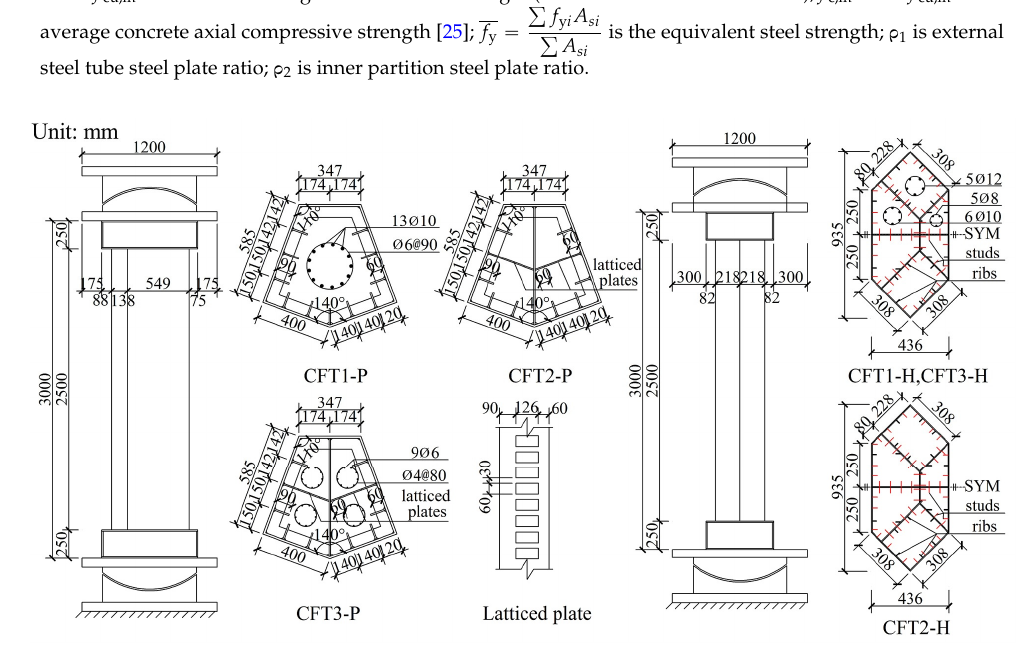
Figure 2. Column construction details.